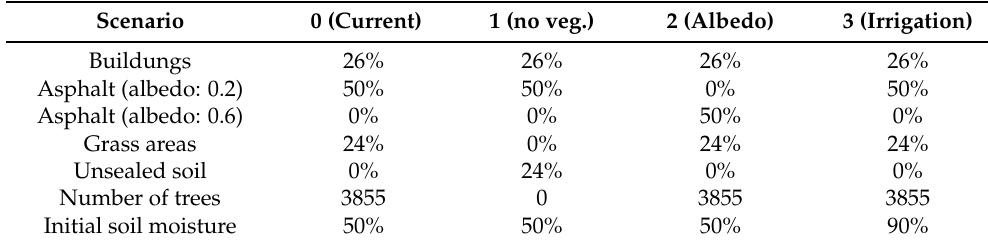
Table 2. Area fractions of the total area for the individual model compartments in % as well as the number of trees in the respective